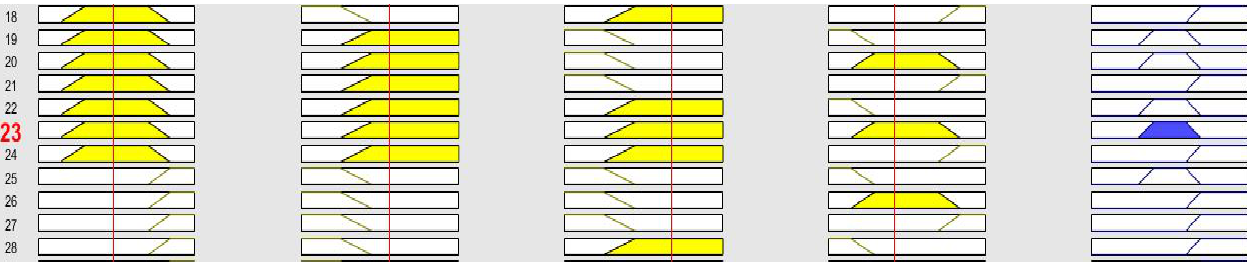
Figure 7. Lookup diagram of Proposed DA-AH-MFES Expert System for No-